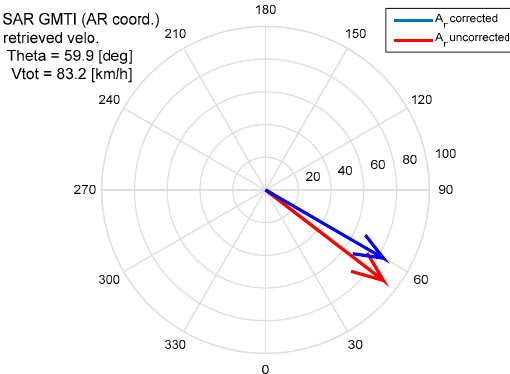
Figure 6. Comparison of two velocity vectors before and after the proposed acceleration compensation for vehicle 3. By compensating the acceleration, the total velocity reduced from 25.2 m / s (90.8 km / h) to 23.1 m / s (83.2 km / h). In addition, the heading direction was adjusted by 7.7 ◦ from 52.4 ◦ to 59.9 ◦ after along-track velocity correction. The zero angle is set to the azimuth direction.